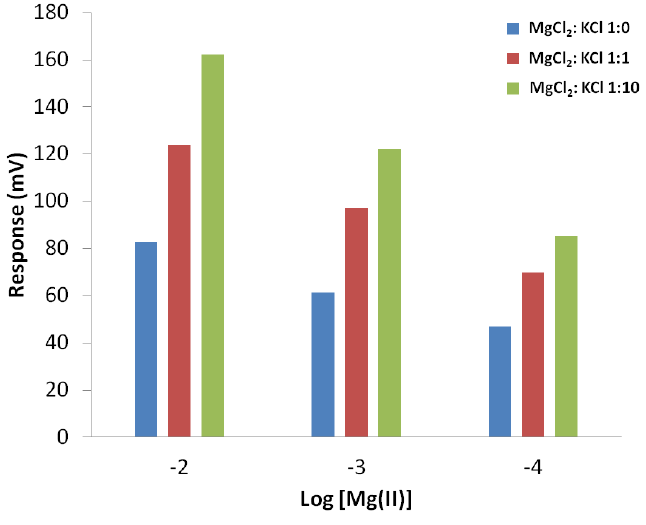
Figure 12. Response of fabricated chemical sensor with cyclopentane carbonitrile immobilized in acrylic copolymer